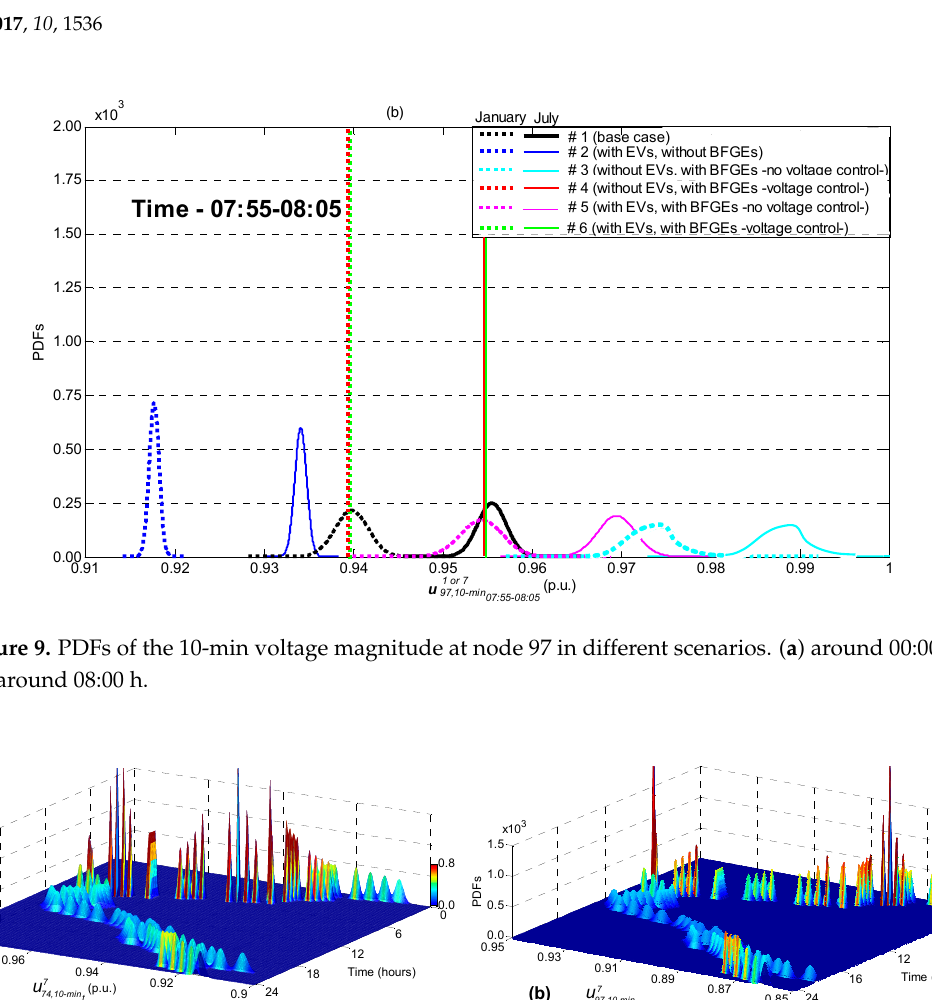
Figure 10. Surface plots based on PDFs of 10-min voltage magnitude during a working day in July for scenario #2. ( a ) node 74; ( b ) node 97. Energies 2017 , 10 , 1536